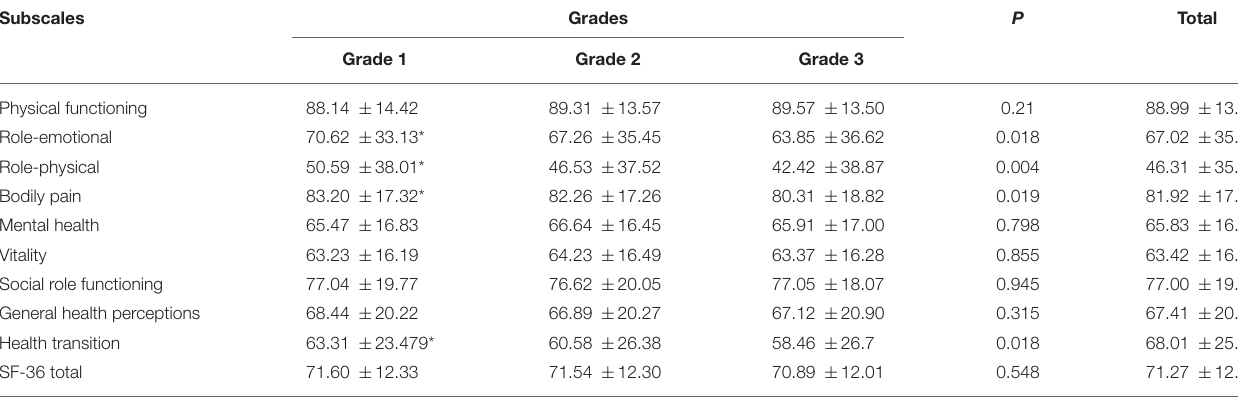
TABLE 2 | Comparison of standardized scores of each subscale for SF-36 among different grades ( x ± s ). Subscales